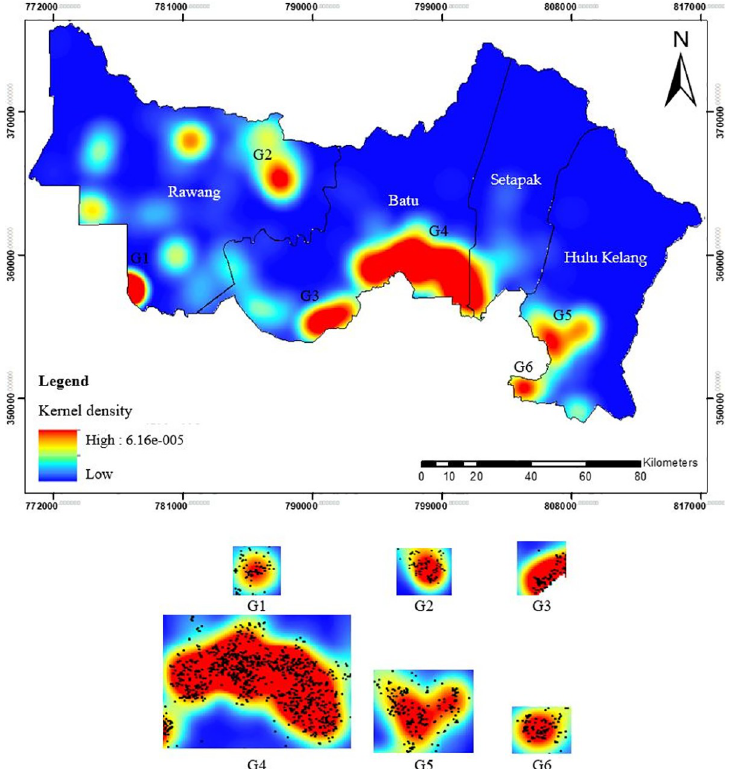
Fig 6. Kernel density map showing the distribution of TB cases in Gombak, 2013 to 2017.